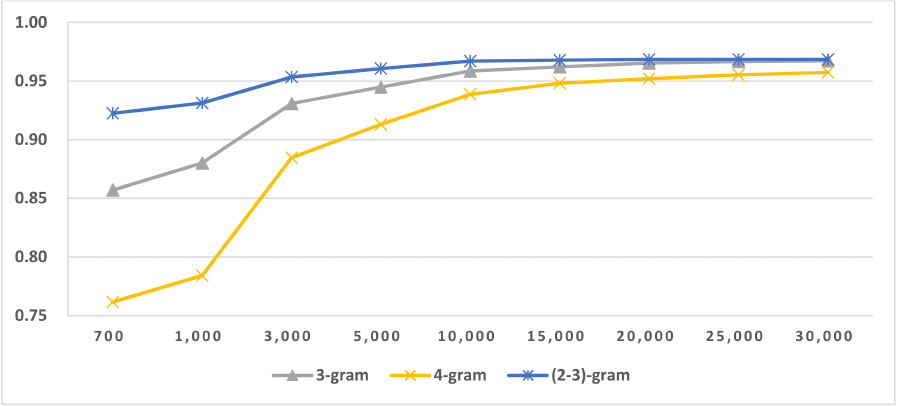
Figure 19. LI in Indo-European/Balto-Slavic in Latin script